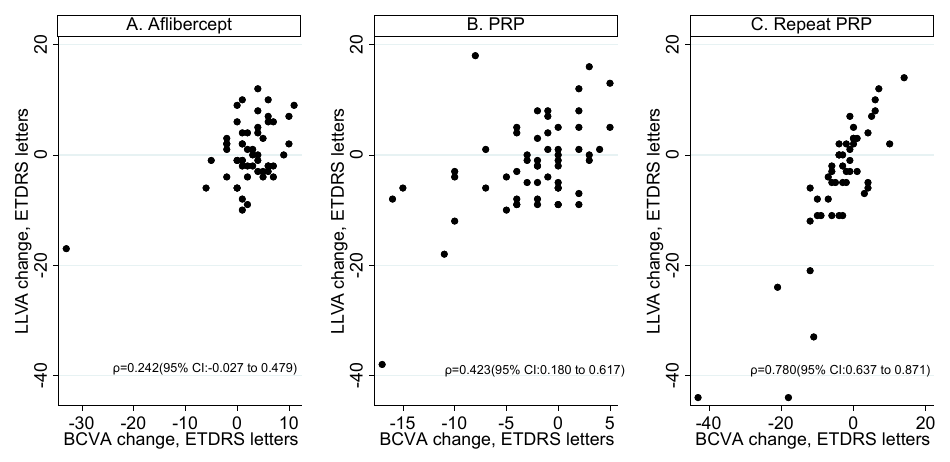
Figure 4. The correlation between change in best corrected visual acuity (BCVA) and low luminance visual acuity (LLVA) was not significant in the ( A ) aflibercept arm; ( B ) Panretinal photocoagulation (PRP) in treatment naïve eyes and ( C ) Repeat PRP.